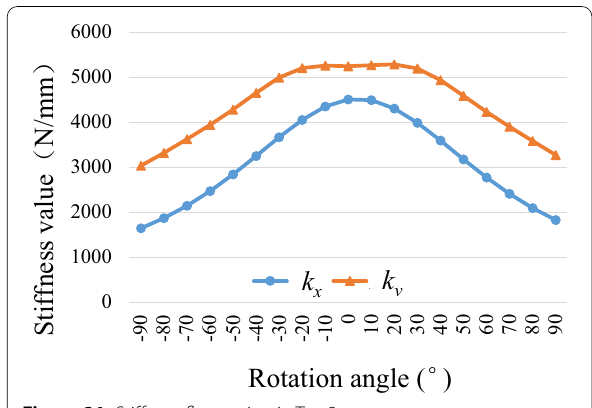
Figure 24 Comparison of k v in different